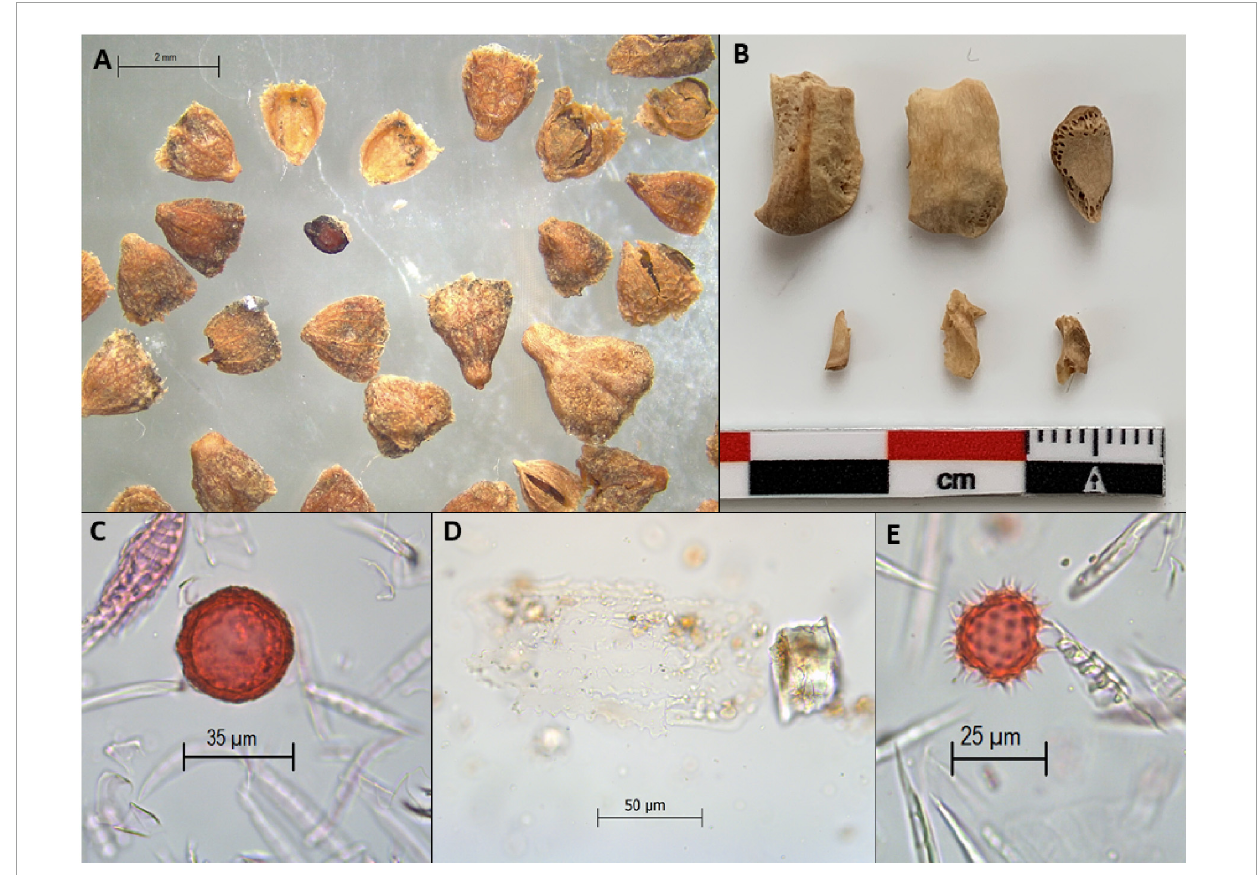
FIGURE3 Examples of macroscopic and microscopic plant and animal remains recovered from Paisley Caves coprolites: (A) Amaranthaceae Atriplex sp. seeds, (B) bone fragments, (C) Taeniidae Taenia sp. egg, (D) conjoined phytolith sheet, (E) Asteraceae pollen.